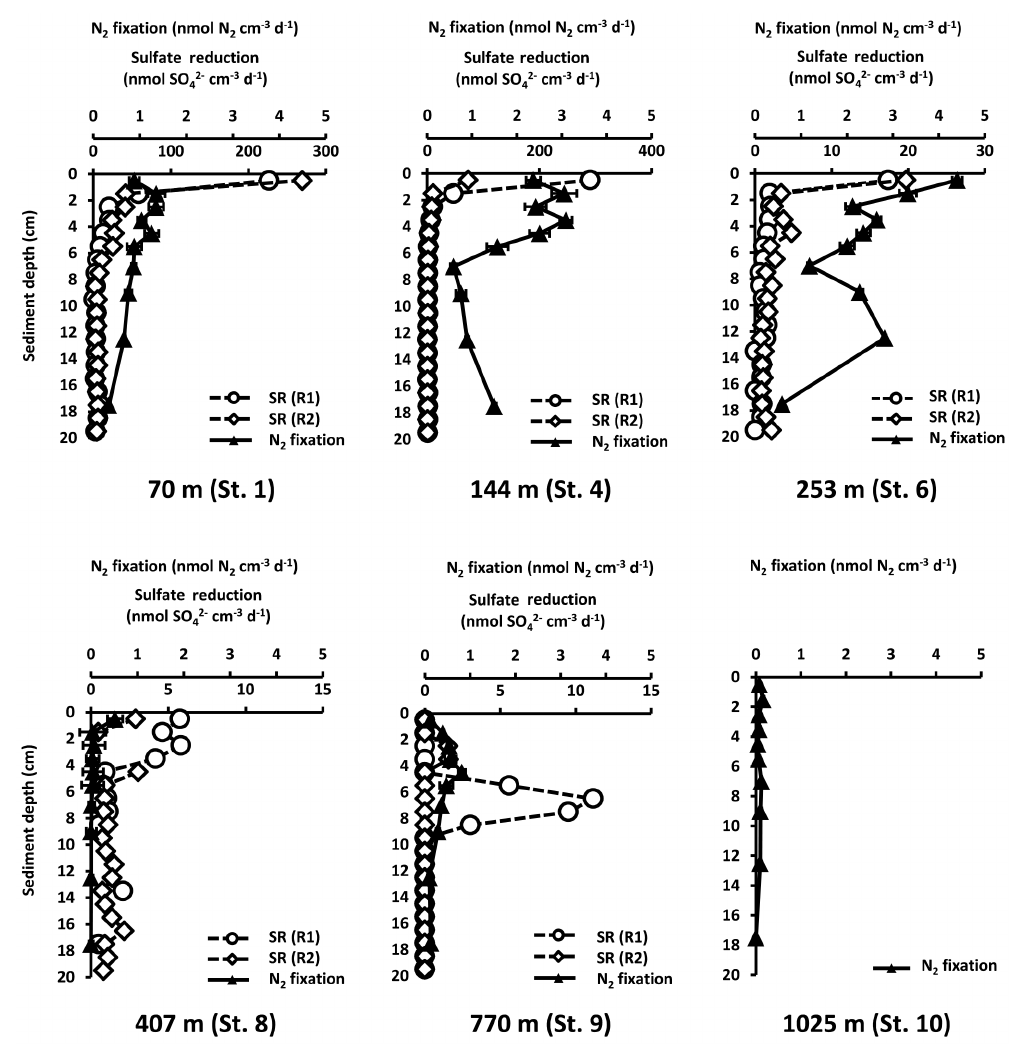
Figure 3. Sediment profiles of N 2 fixation (nmolN 2 cm − 3 d − 1 , average of three replicates) and sulfate reduction rates (SR, nmolSO 2 − cm − 3 d − 1 , two replicates; R1 and R2) from 0 to 20cm at the six stations. The upper x axis represents the N 2 fixation, while the 4 lower x axis represents the SR. Error bars indicate standard deviation of N 2